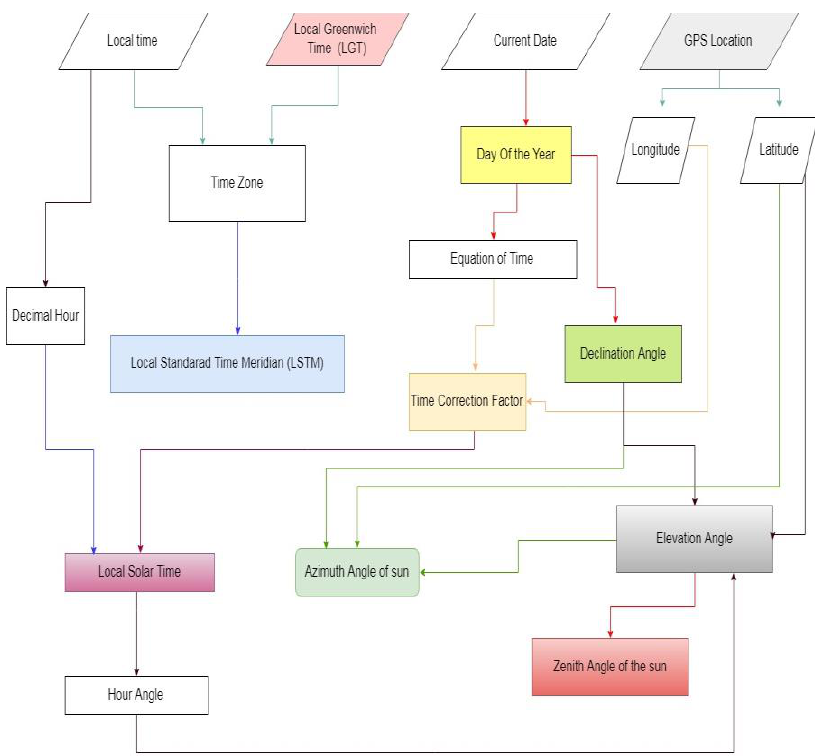
F IGURE 2: F LOWCHART FOR CALCULATION OF S UN ’ S AZIMUTH AND ZENITH